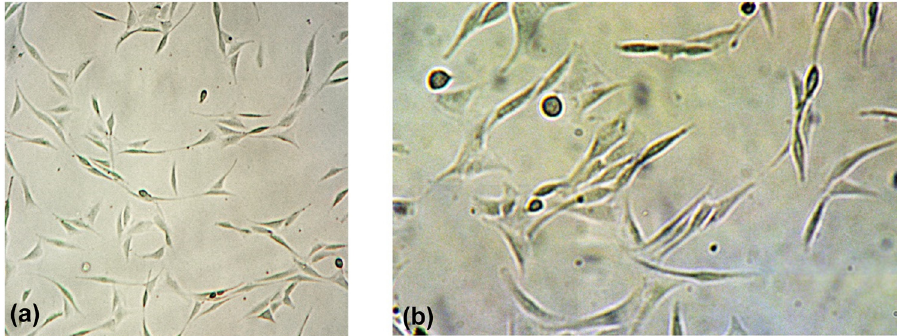
Figure 1: MC3T3 - E1 cells 1 day after subculture. ( a ) (× 40 magni fi cation ) and ( b ) (× 100 magni fi cation )